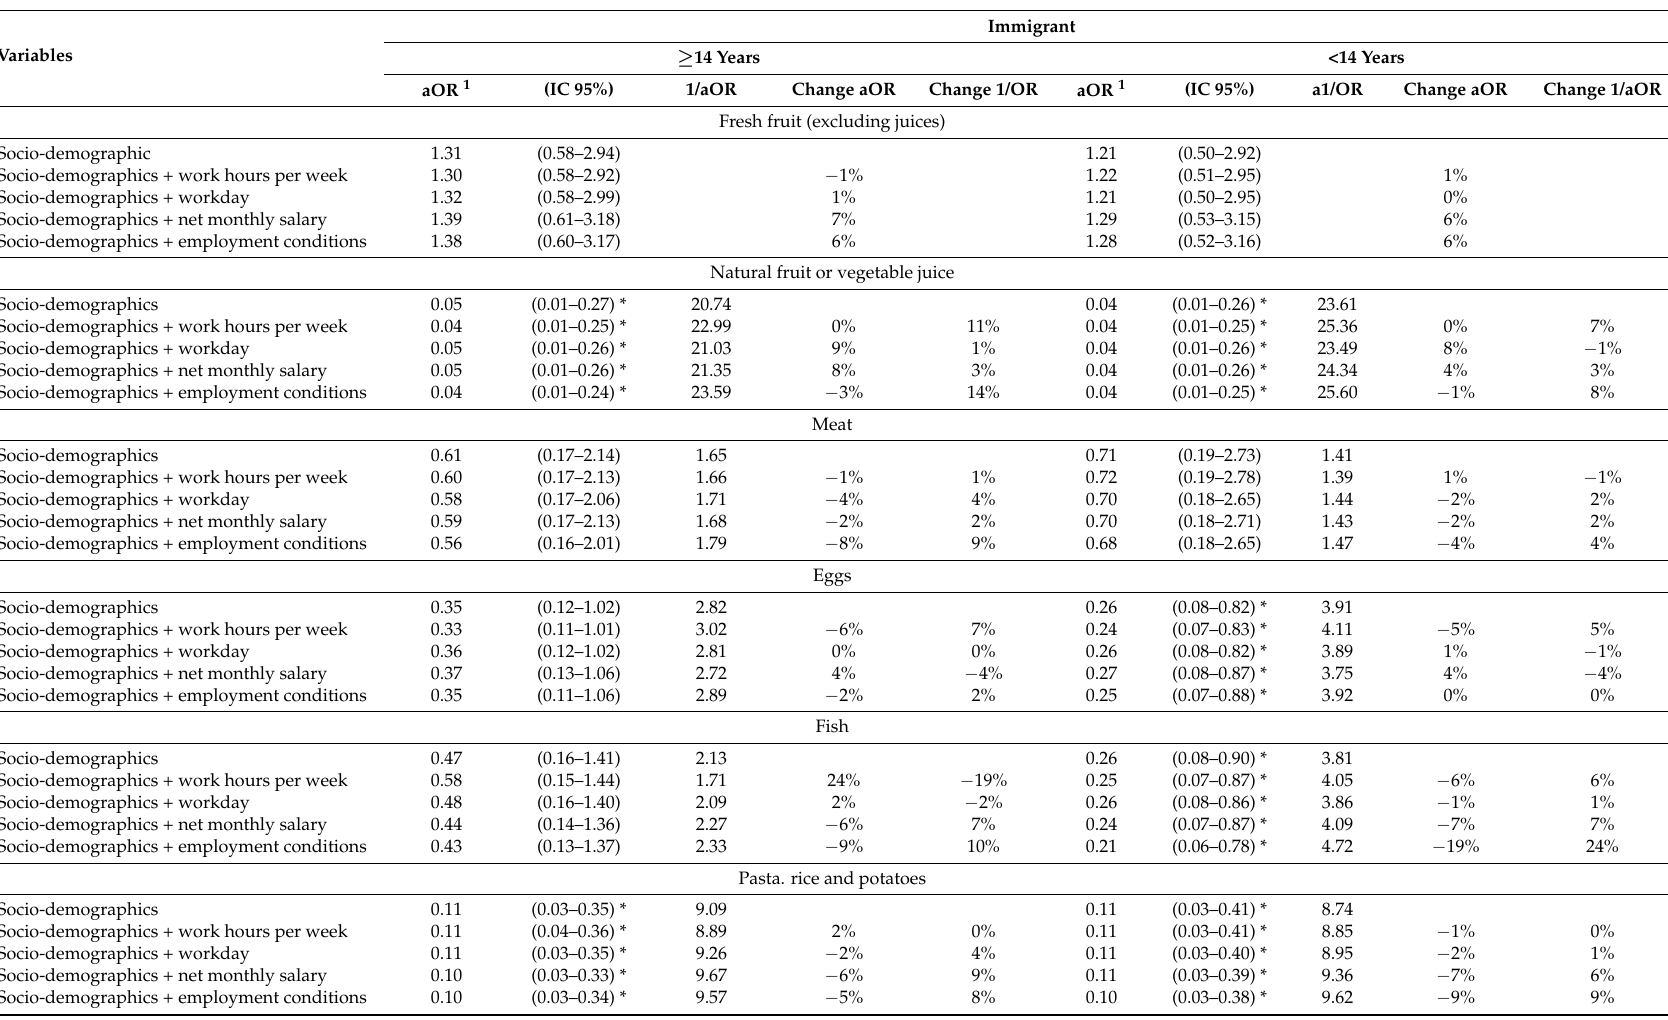
Table 3. Association (Adjusted Odds Ratio (aOR) with 95% Confidence Intervals) of Adherence to Dietary Recommendations for Food Groups by Migratory Status, and change in association by employment